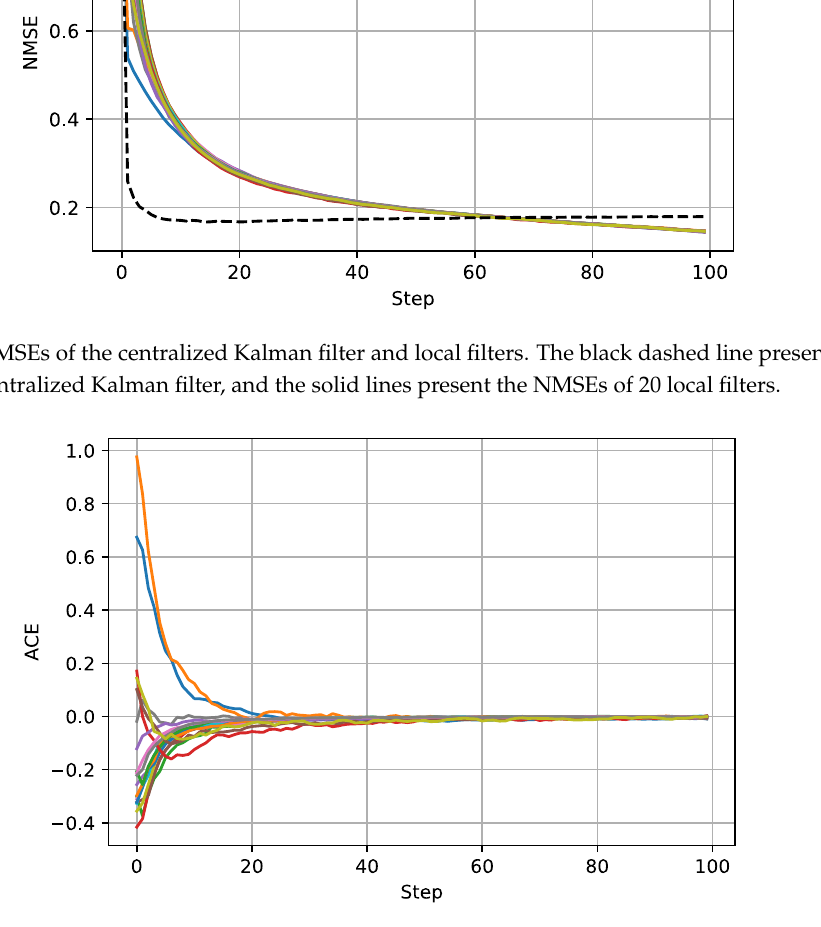
Figure 4. Average consensus errors (ACEs) of 20 local